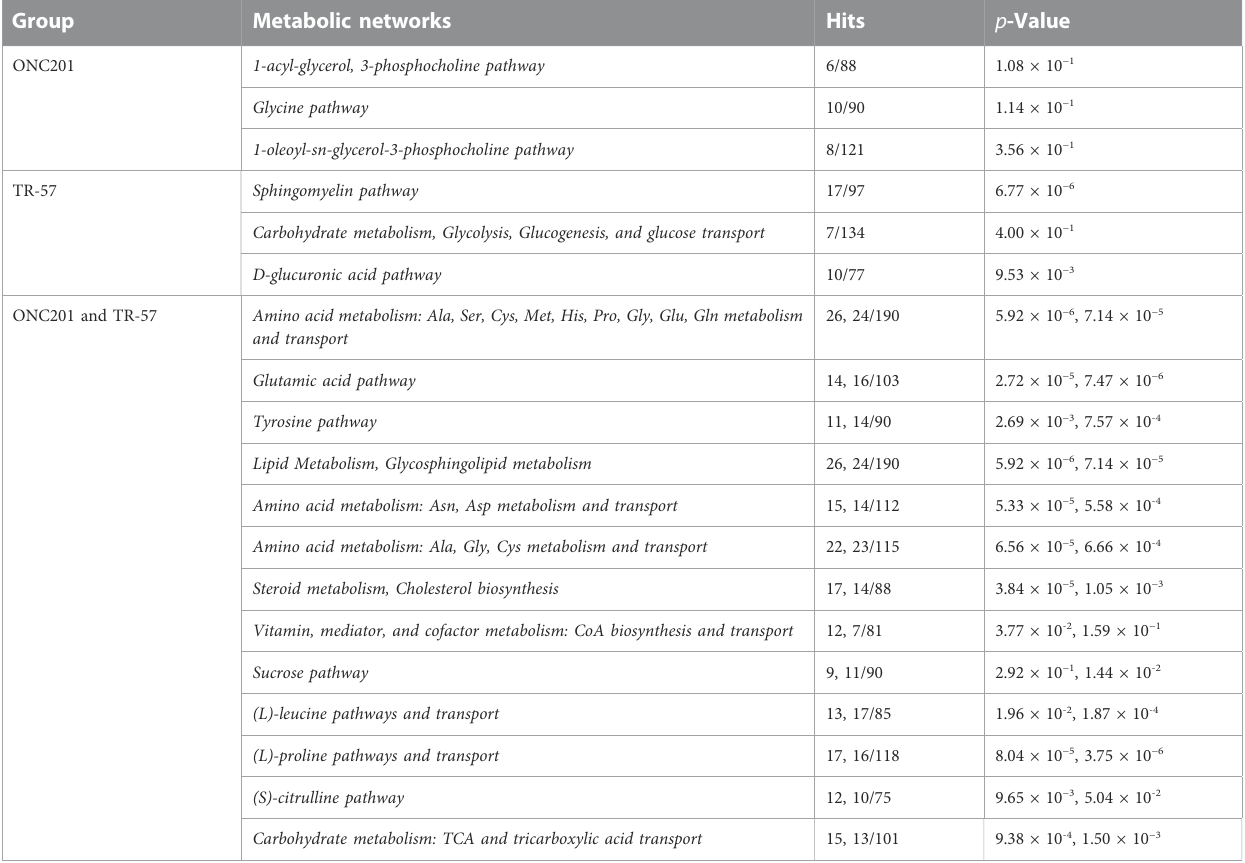
TABLE 1 ClpP activation perturbs many metabolic pathways across proteomic, transcriptomic, and metabolomic landscapes in triple-negative breast cancer cells. Representative top endogenous metabolic networks (EMN) identi fi ed using MetaCore for each group, as outlined in Figure 3. Number of hits (perturbed EMN members) and p -value are listed for each dataset in the order they appear in the group name.